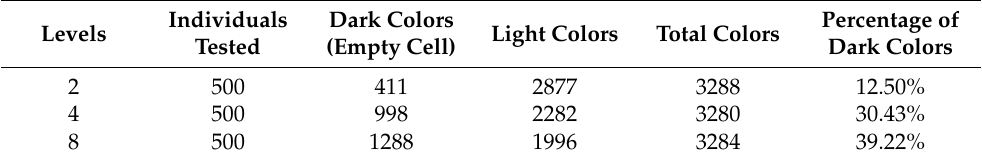
Table 2. Incrementing color levels leads to 50% void/fil ratio. Individuals Levels Tested